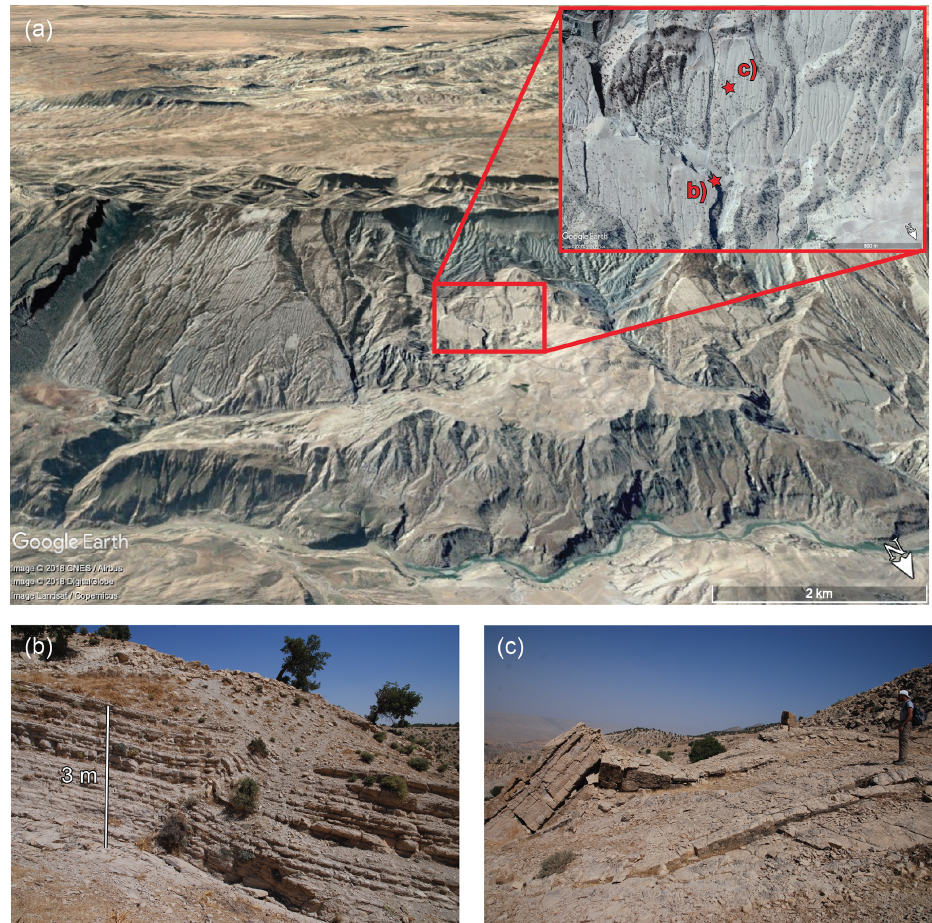
Figure 11. Scar area of the Seymareh landslide. (a) Front view of the scar area with the location of sites where evidence of buckling has been recognized (Source © Google Earth: Image © 2018 CNES/Airbus, Image © 2018 DigitalGlobe, Image © Landsat/Copernicus); (b) ductile buckling deformations within the layers of the upper Pabdeh member which cannot be referred to as parasitic structural folding due to their localization just below the Seymareh landslide sliding surface and to their reduced persistency (both lateral and vertical) within the rock mass; (c) brittle buckling deformation of the Taleh Zang member along the scar